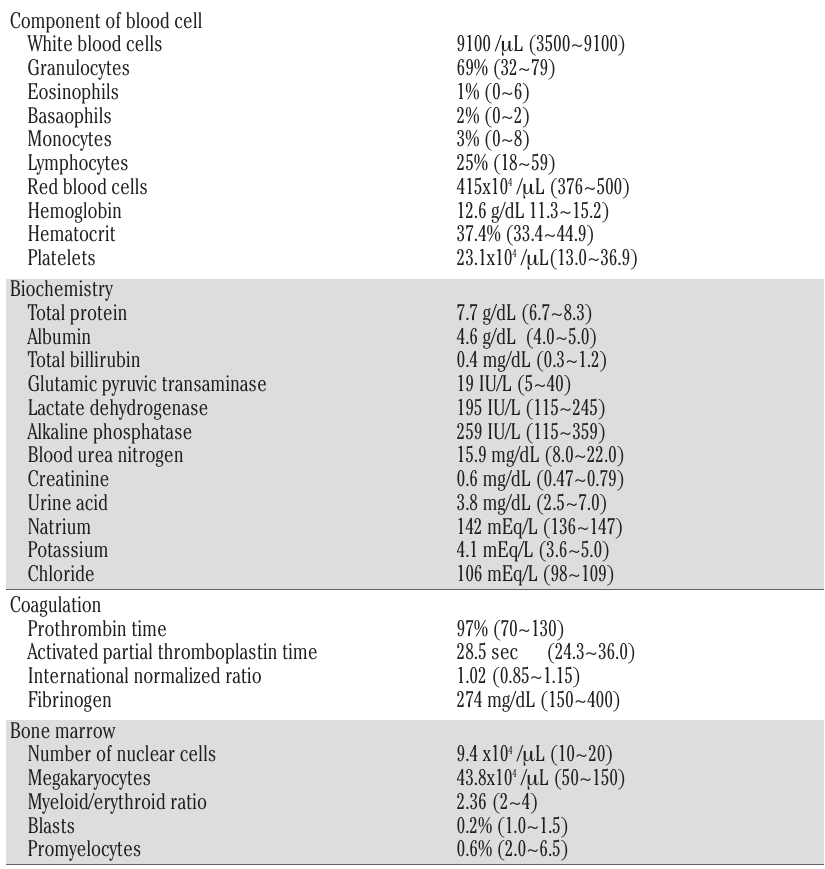
Table 1. Laboratory data on admission. The profile of the peripheral blood cell count was within the normal range. Biochemical data showed a normal LDH level and no organ disorders. Cytogram of bone marrow revealed no obvious morphological changes and the involvement of lymphoma cells was not detected. Component of blood cell White blood